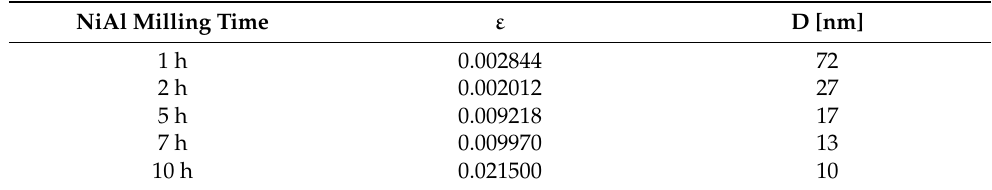
Table 2. Estimated structure size and strain factors based on Williamson–Hall plots for NiAl powders after various milling